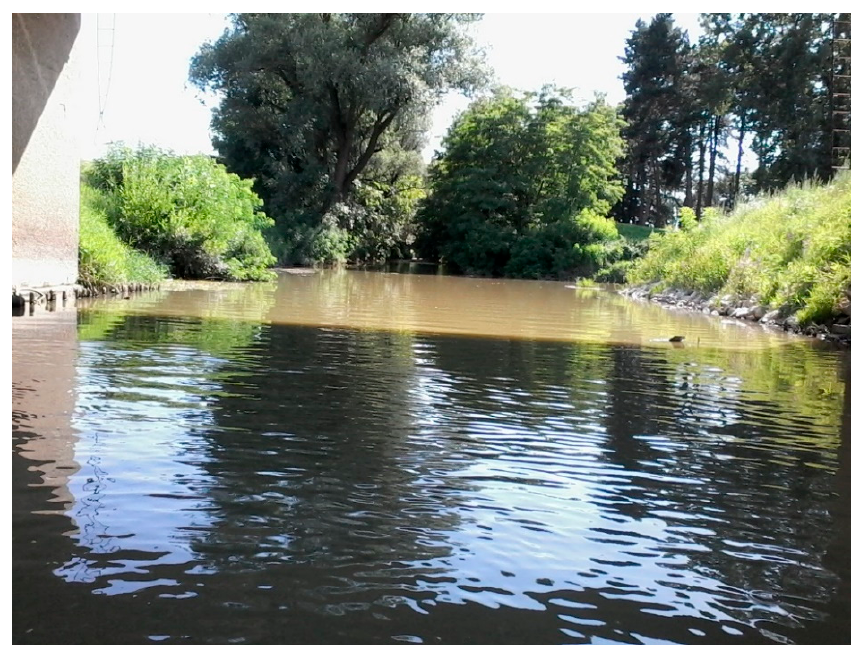
Water 2021 , 13 , 1777 Figure A1. View at the location of the measuring station Ludbreg on the Bednja River.